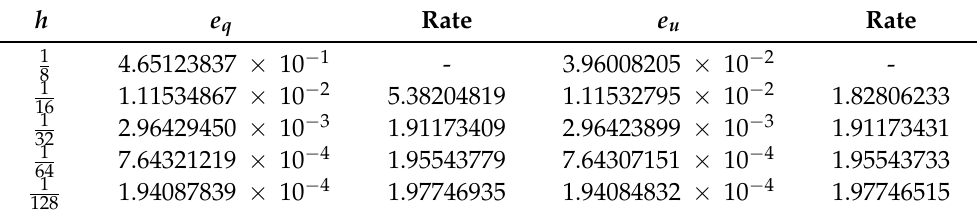
Table 10. Error e q and e u for the time convergence rates with α =